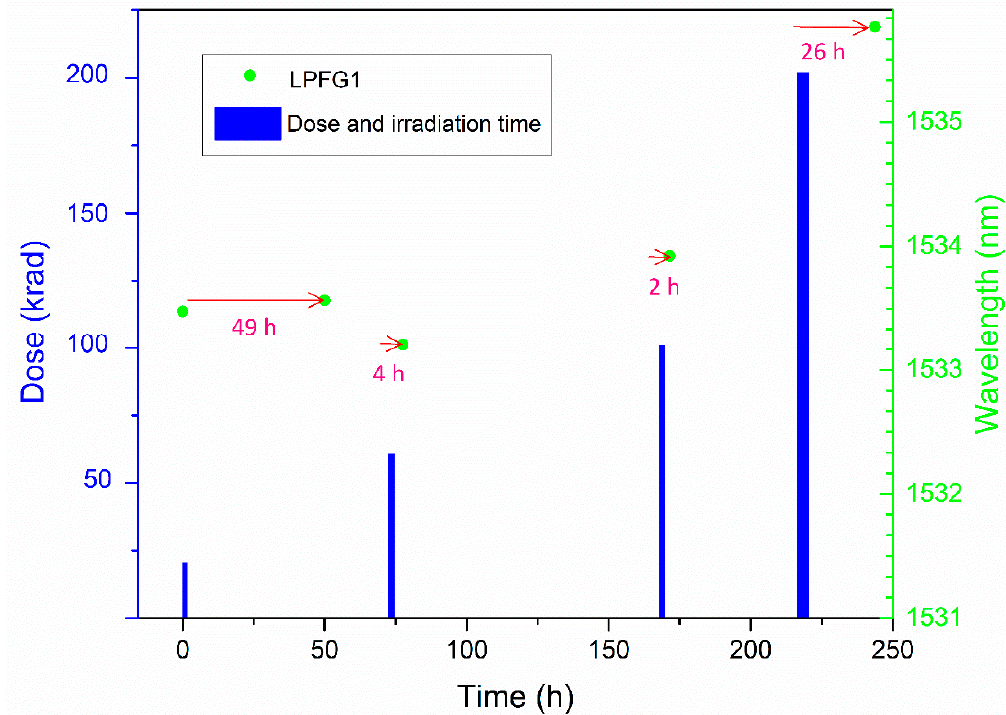
Figure 4. Test campaign irradiation and dip wavelengths measurements versus time. Bars: the width of the bars indicates the exposure time to irradiation for each step (20 krad: 0.62 h; 60 krad: 1.22 h; 100 krad: 1.22 h and 200 krad: 3.03 h). Circles: LPFG1 DWS measurements; the arrows show the time elapsed between irradiation and measurement moment.